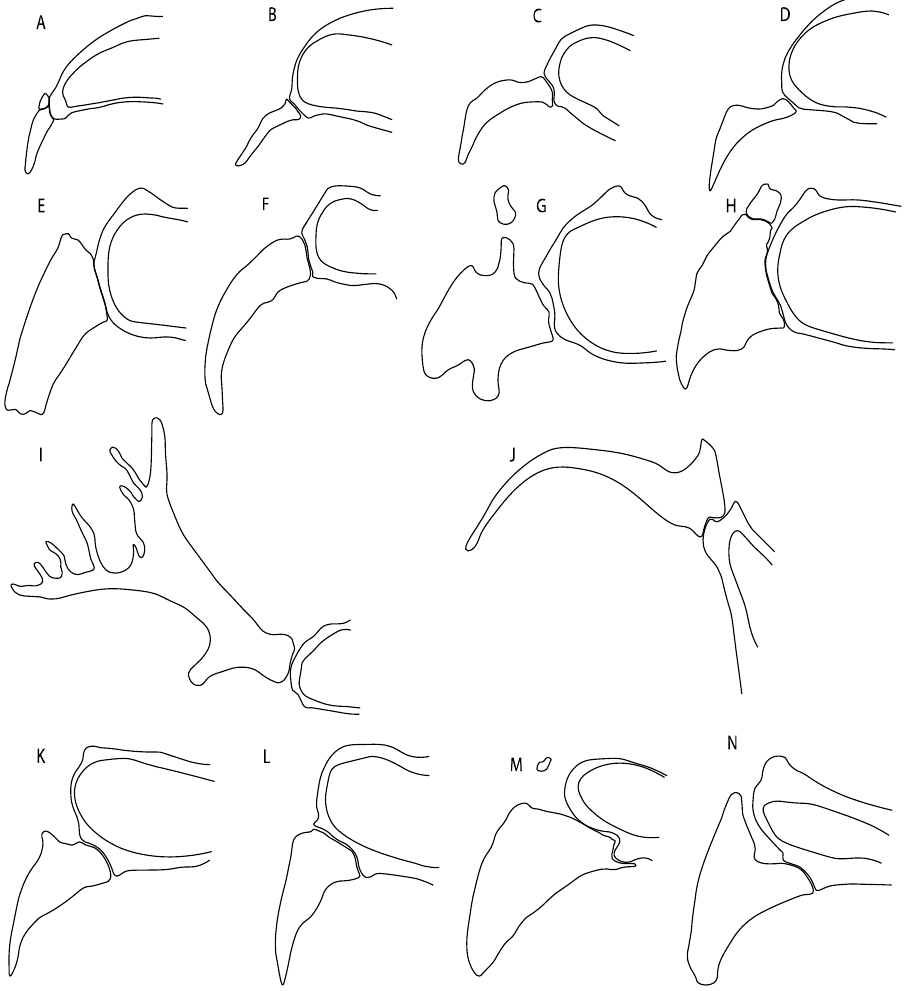
Figure 14. Interpretative drawings of ventral views of the nasal capsules and antorbital cartilages in ventral views. State (0): ( A ) Zanobatus sp. (MNHN 1989. 12. 91); ( B ) Urotrygon chilensis (FMNH 93737) redrawn and modified from de Carvalho Text-Figure 33B in [67]; ( C ) Raja clavata (BRC–Raja); ( D ) Bathyraja leucomelanos (MNHN 2005-2740) redrawn and modified from Iglésias and Hartmann Text-Figure 11 in [84]; ( E ) Zapteryx xyster (CNPE IBUNAM 16661); ( F ) Aptychotrema vincentiana (CSIRO 101, https://sharksrays.org/ (accessed on 12 April 2020)); ( G ) Platyrhinoidis triseriata (MNHN 3211);